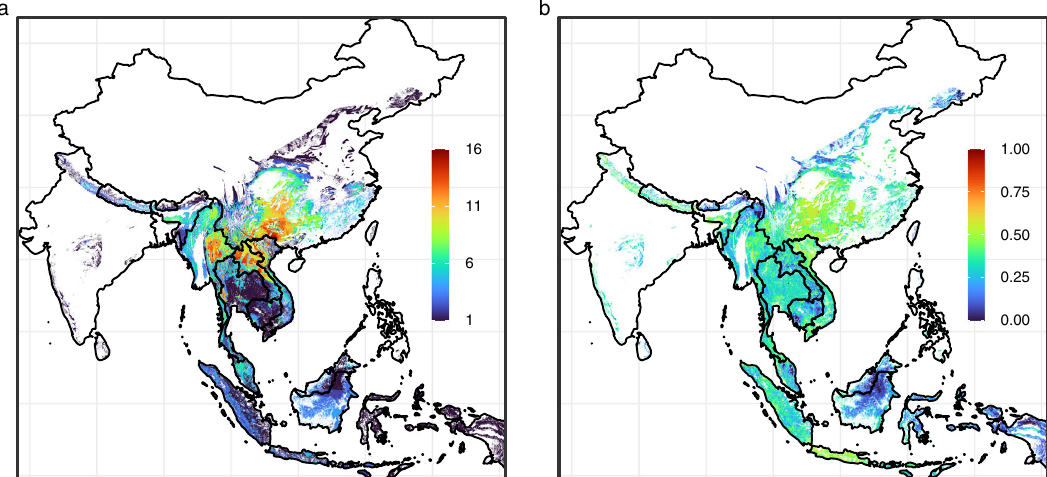
Fig. 2 Hotspots of SARSr-CoV bat host species richness and human overlap in Southeast Asia. a Species richness of SARSr-CoV bat host species in Southeast Asia, created by overlaying area of habitat maps for all 26 SARSr-CoV bat host species known for this region. b Relative bat-human overlap: bat host species richness multiplied by human population count. Values were ln( x + 1) transformed and then normalized to a 0 – 1 scale. For both panels, redder colors indicate larger values and bluer colors indicate smaller